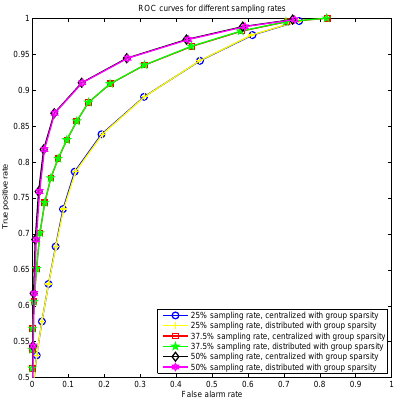
Figure 6. ROC curves at different numbers of PUs MSE of spectrum sensing for 7 PUs by the centralized algorithm with group sparsity is around 0 . 06.